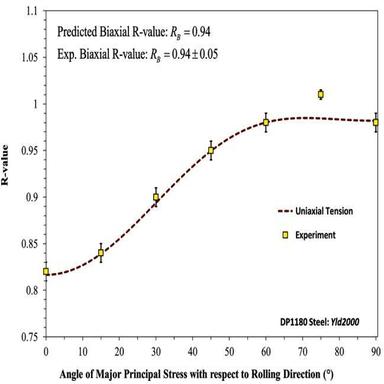
Comparison of the experimental and predicted R-values of DP1180 steel using the associated Yld2000 yield function. The experimental biaxial R-value was measured using disc compression tests.